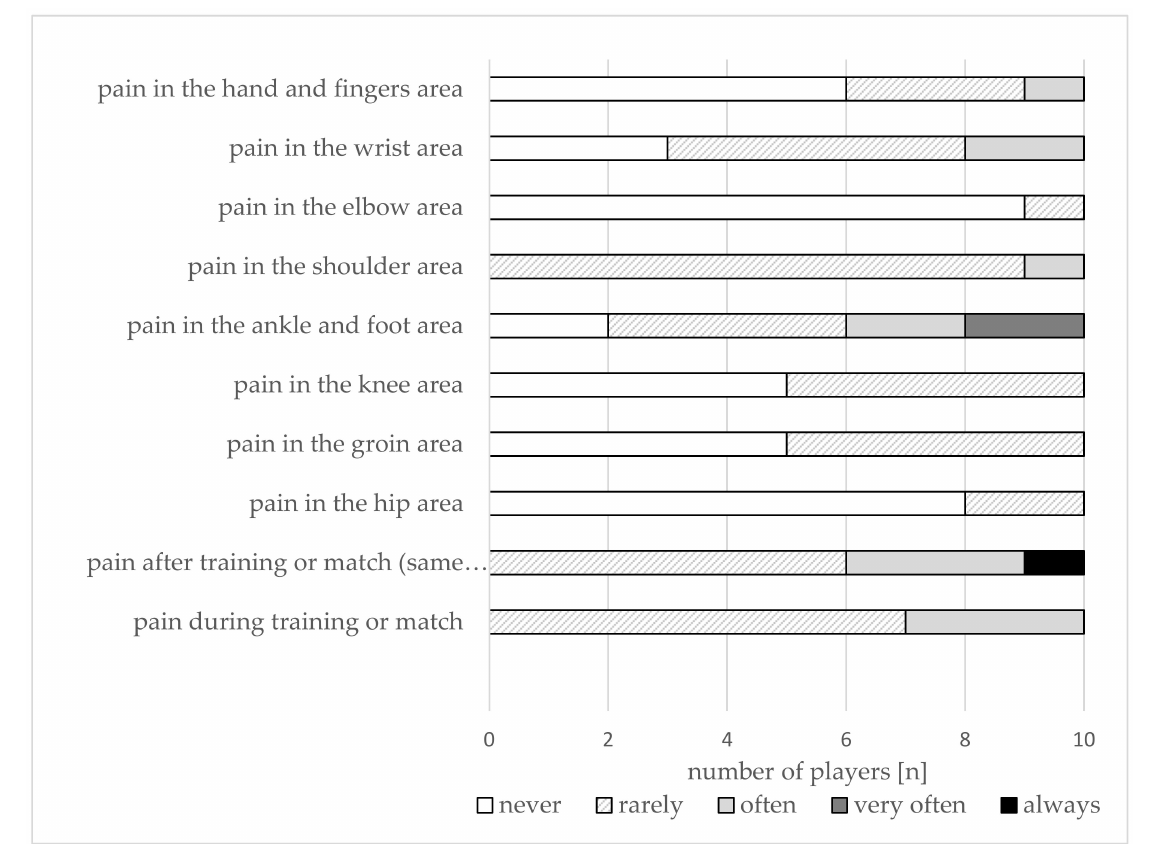
Figure 2. The frequency of pain across different body areas as a result of training and matches in Amputee Football field players (n = 10).